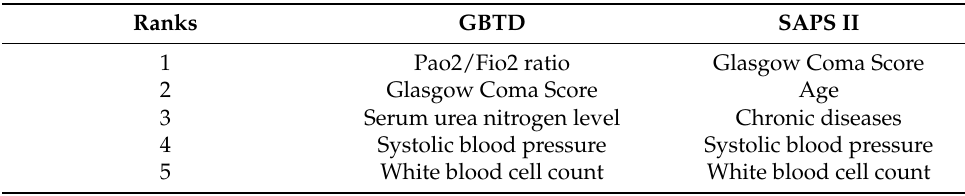
Table 5. Top five important variables identified by GBDT and SAPS II.